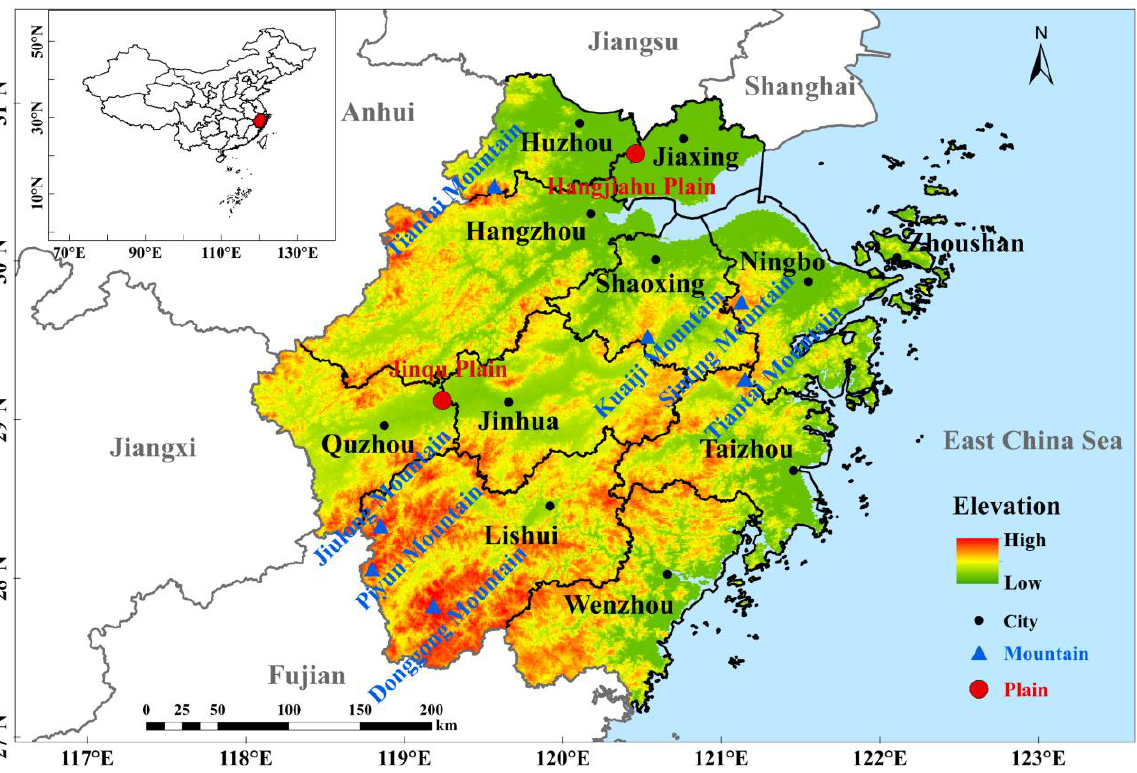
Figure 1. Map of Zhejiang province in China.